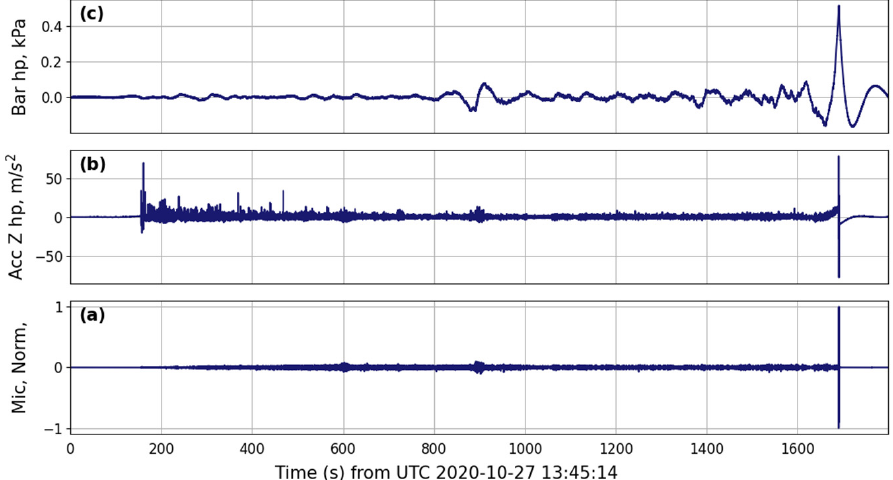
Figure 13. Sensor payloads for ( a ) audio, ( b ) high-pass filtered Z-component of acceleration, and ( c ) high-pass filtered barometric pressure.